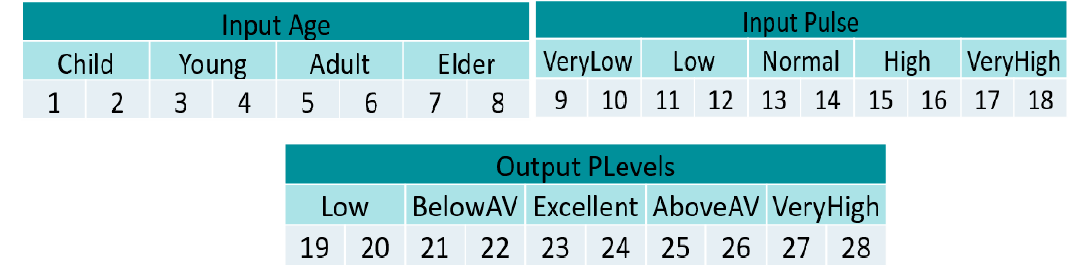
Figure 11. FIS representation in the BSA with Gaussian MFs.